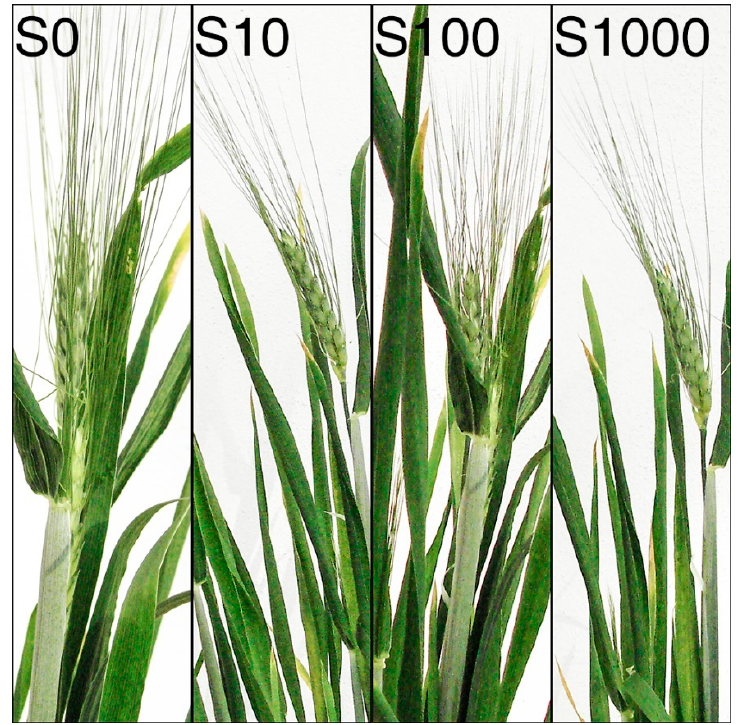
Figure 5. Development of heads in the spring variety after 60 days of growth. Variety: Sirael (S); Concentrations of GA 3 : 0, 10, 100 a 1000 mg L − 1 ; Phenological stage: head emergence.